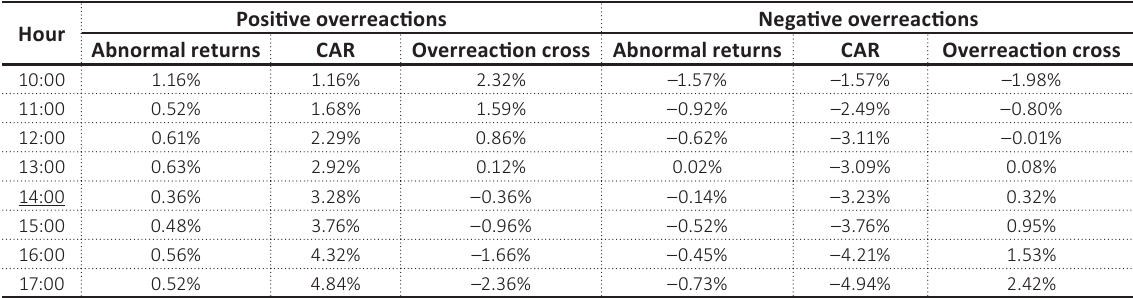
Table 3. Cumulative abnormal returns: case of positive and negative overreactions, UX-C